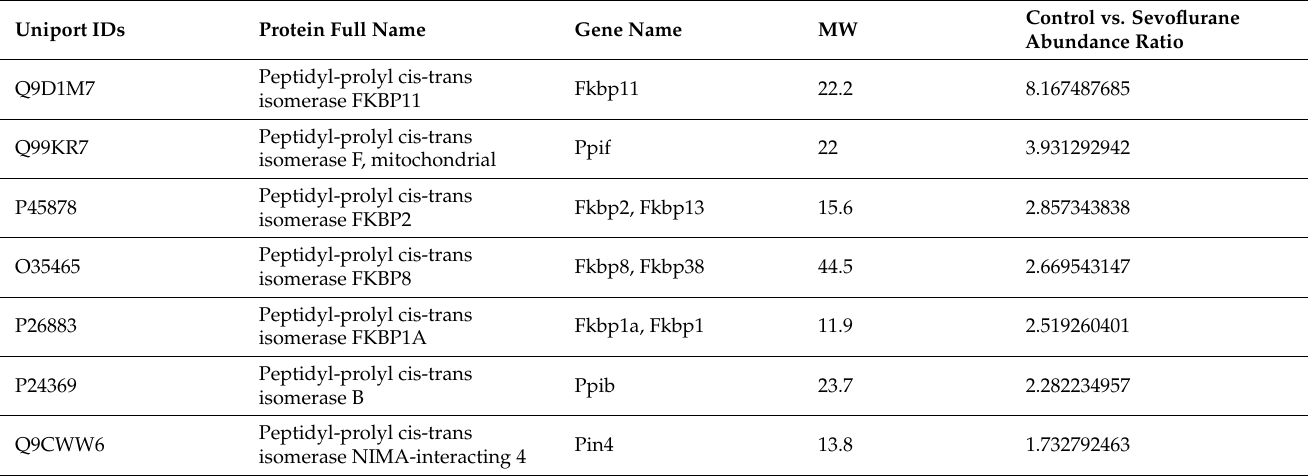
Figure 5. Proteomics analyses identify mitochondrial proteins in the hippocampus of mice. ( A ) Experimental design and workflow for quantitative profiling of mice hippocampus mitochondrial proteomics after the sevoflurane anesthesia. ( B ) Quantitative proteomic analysis of the abundance ratio of Peptidyl-prolyl cis-trans isomerase ( Ppif ) associated proteins after the sevoflurane anesthesia. ( C ) Sevoflurane treatment (lanes 4 to 6) discernibly increases the levels of CypD as compared to the control condition (lanes 1 to 3) in the hippocampus of WT mice; there is no significant difference in β -actin levels between the groups. Table 1. The summary of identified Peptidyl-prolyl cis-trans isomerase proteins regulated by sevoflurane anesthesia.